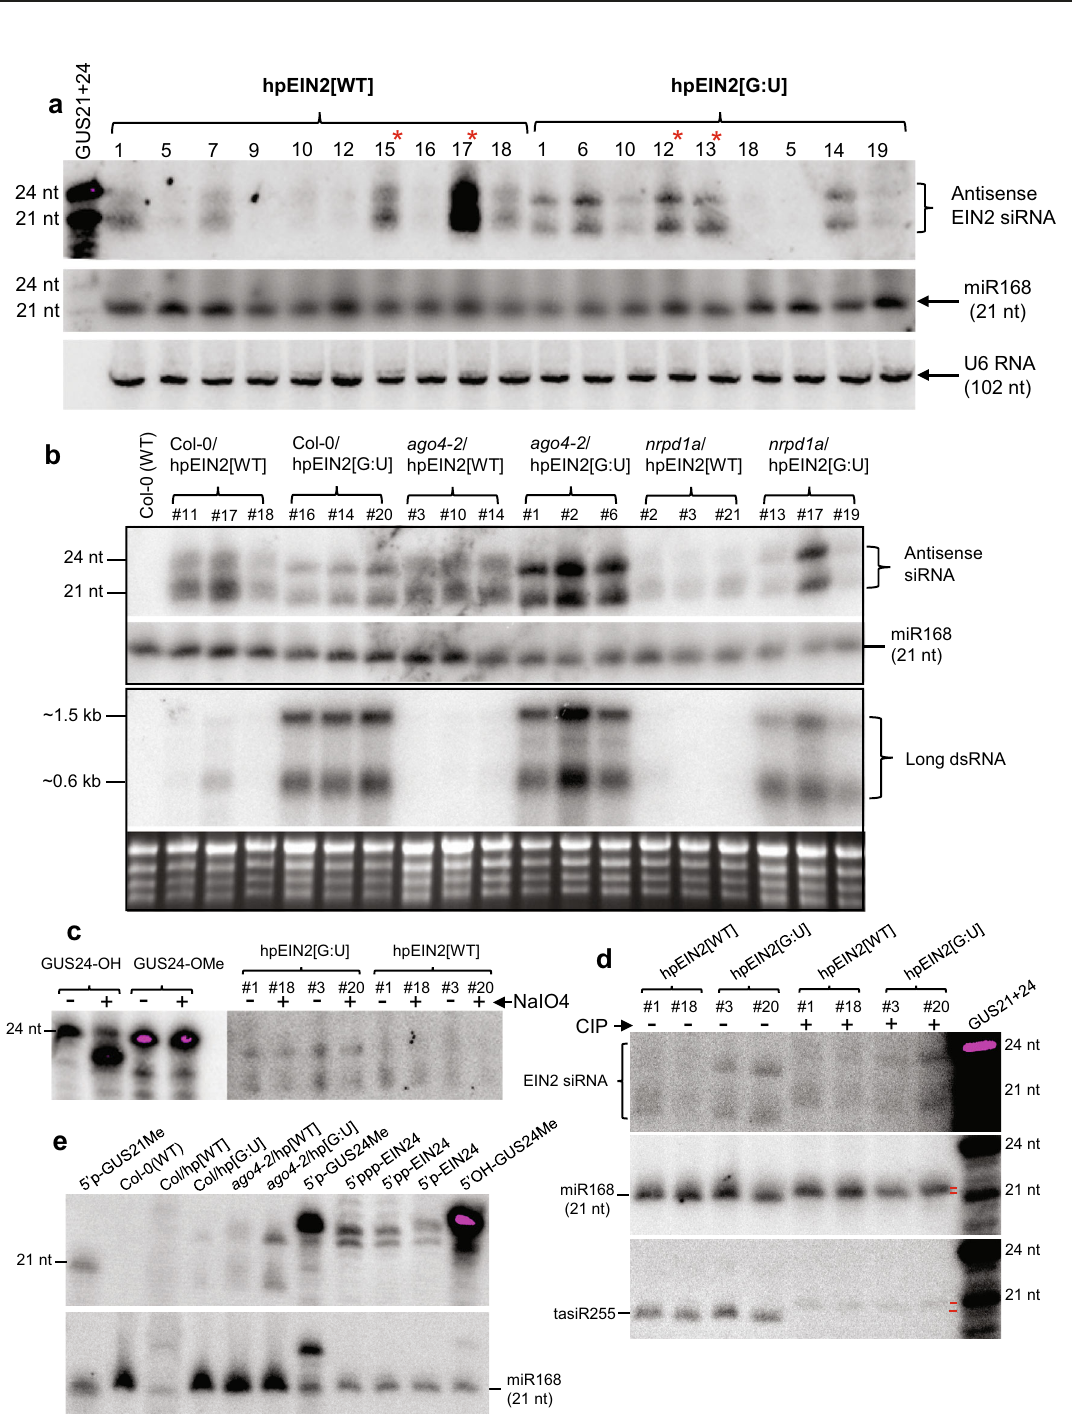
Fig. 6 Heavy DNA methylation in the traditional hpEIN2[WT] transgene is retained in AGO4 mutant ago4-2 or the PolIV mutant nrpd1a-3 . Yellow- highlighted areas represent the IR (left) and target EIN2 genomic (right) regions. Left, both promoter and IR DNA methylation of hpEIN2[WT] is retained in the ago4-2 and nrpd1a-3 mutants, with hpEIN2[G:U] showing almost no methylation in the 35S promoter except for the nrpd1a-3 /hp[G:U]-3 line. Note that only the top strand was analyzed; the 140 bp EIN2 sequence in hpEIN2[G:U] has no cytosines in the top strand so the low levels of signals re fl ect the background cytosine noises in the sequencing trace fi les. Right, methylation levels of the hpRNA-targeted EIN2 genomic sequence (top strand only), show much lower levels of CHG and CHH methylation than the hpEIN2[WT] sequence on the left, particularly in the nrpd1a /hpEIN2[WT] lines. The asterisks underneath the graph indicate the CG sites that were already densely methylated in the untransformed Col-0, ago4-2, and nrpd1a backgrounds (Supplementary Fig. 8). Source data are provided as a Source Data fi